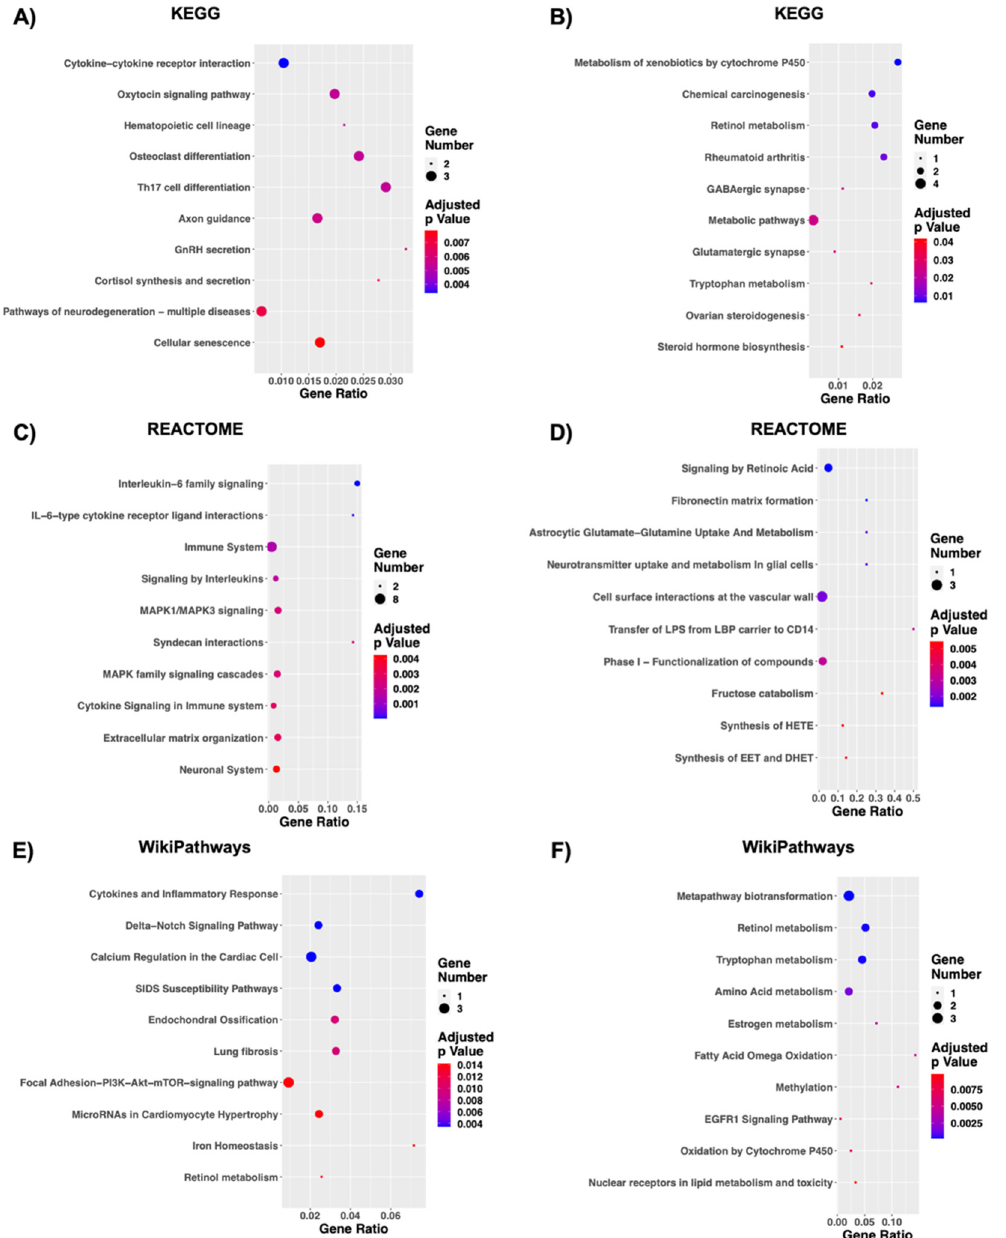
Figure 5. KEGG, Reactome, and WikiPathways enrichment analysis of co-expression modules. On the basis of the turquoise and blue modules we performed a functional enrichment analysis via the g:Profiler web tool by ranking genes according to |log 2 FC|. The top 10 deregulated pathways according to their significance are displayed. A significant deregulation was observed in KEGG, Reactome, and WikiPathways. KEGG ( A , B ) highlighted respectively 59 significantly deregulated pathways for the turquoise module and 25 for the blue one. Reactome ( C , D ) highlighted 151 pathways emerged as significantly deregulated for the turquoise module and 59 for the blue one. WikiPathways ( E , F ) highlighted 16 significant terms from turquoise module and 14 from the blue one. The y -axis represents the name of the pathway, the x -axis represents the Rich factor, dot size represents the number of different genes, and the color indicates the adjusted p value.